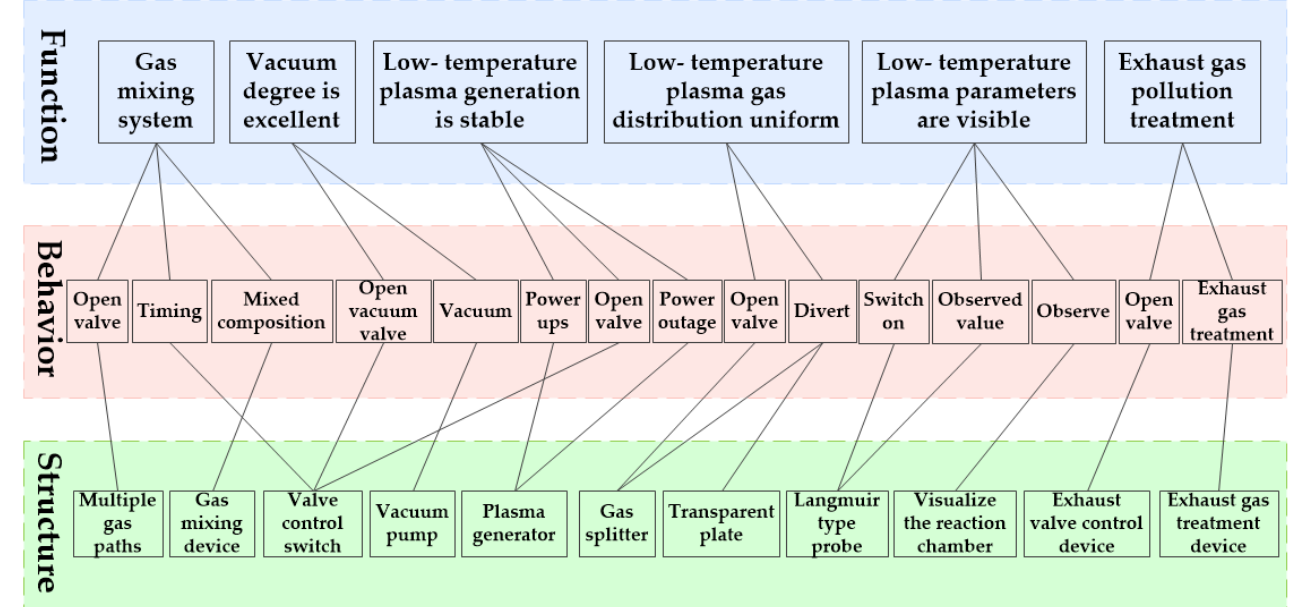
Figure 3. The FBS map of the low-temperature plasma deposition